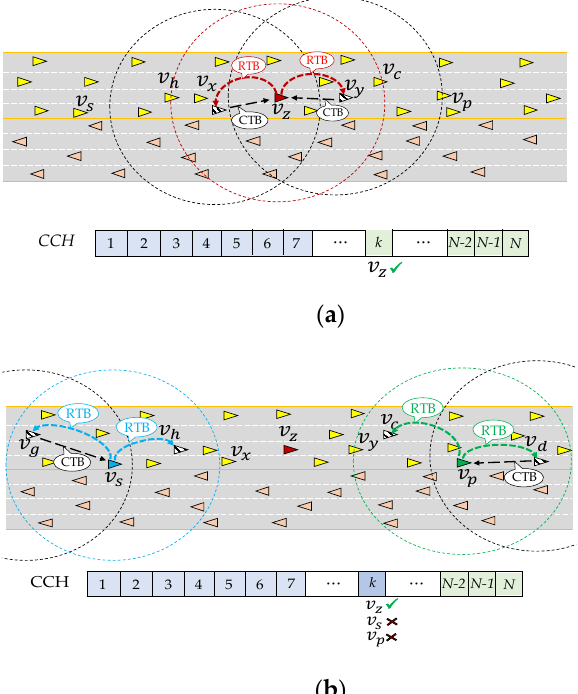
Figure 6. Slot acquisition procedure: ( a ) success scenario; ( b ) failure scenario.